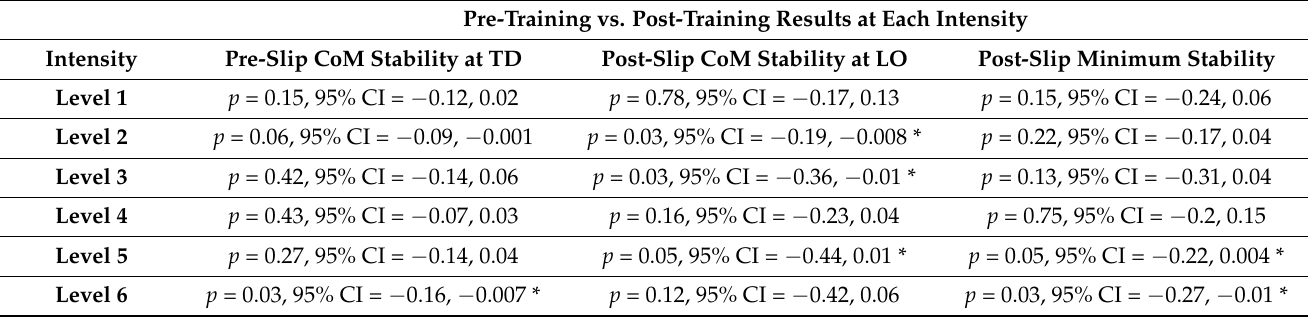
Table 3. Planned comparison results for pre- and post-slip stability using paired t -tests with 95% confidence interval. Pre-Training vs. Post-Training Results at Each